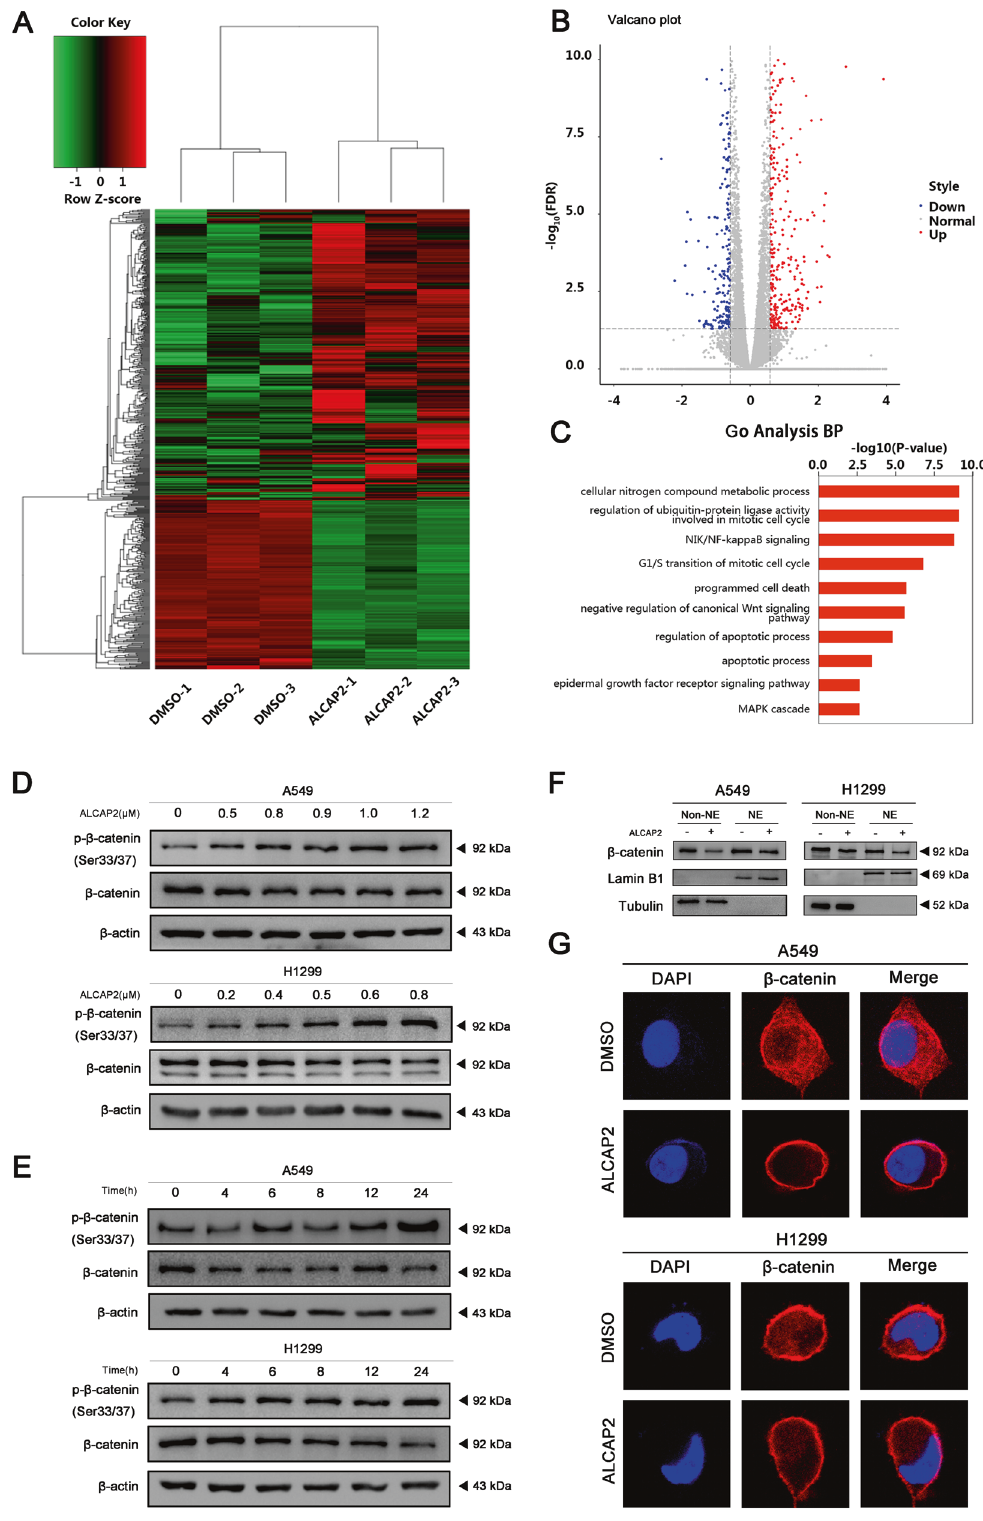
Fig. 4 ALCAP2 suppresses the total and nuclear protein levels of β -catenin. A – C Heat map of differentially expressed mRNAs in the treatment and control groups. A total of 592 genes were identi fi ed [false discovery rate (FDR) <0.05 and absolute fold change (FC absolute) >0.585], among which there were 373 were upregulated and 219 were downregulated. Then, we performed a GO enrichment analysis of these genes. D A549 and H1299 cells were treated with different concentration of ALCAP2 for 24 h, cells were lysed with 1 ml of RIPA buffer for western blot. E A549 were treated with 1.0 μ M ALCAP2 and H1299 treated with 0.6 μ M ALCAP2 for different time, then cells were lysed with 1 ml of RIPA buffer for western blot. F A549 and H1299 cells treated with or without ALCAP2 were subjected to cellular fractionation followed by western blotting for detecting β -catenin. Tubulin and Lamin B1 are endogenous markers of cytosolic and nuclear proteins (NE: Nuclear, Non-NE: Cytoplasmic). G Immuno fl uorescence staining of β -catenin after A549 and H1299 cells were treated with or without